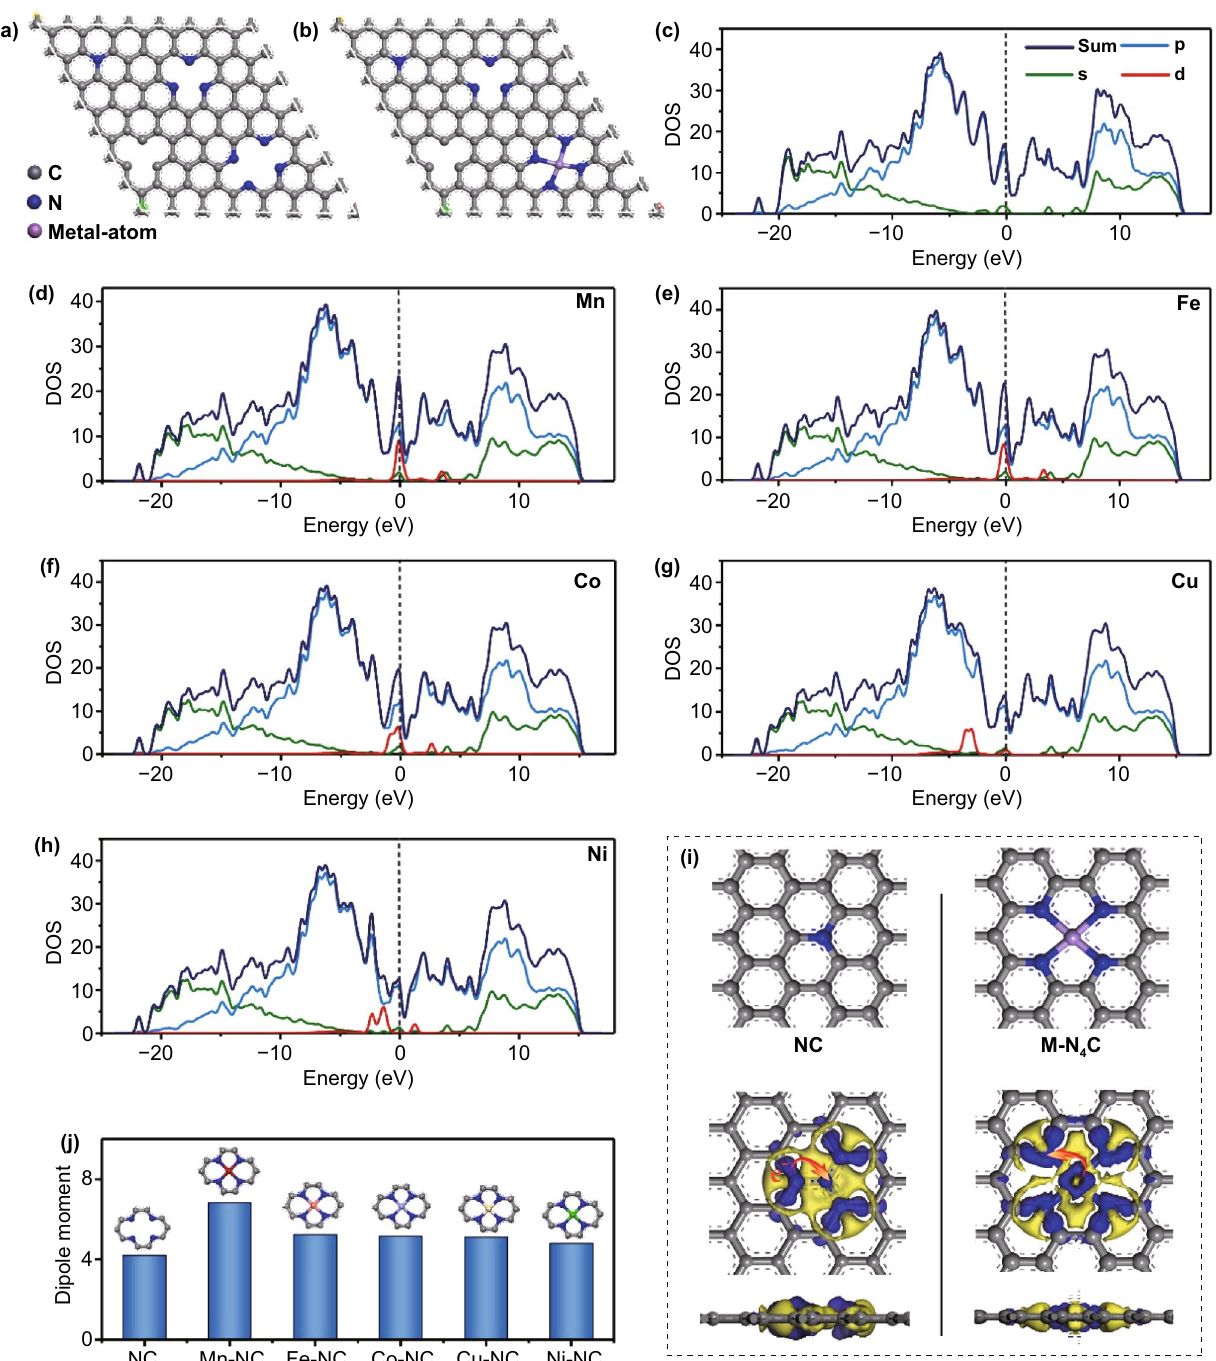
Fig. 6 Schematic structural models of a NC and b M–N 4 C structures. c–h Calculated DOS of the NC and M–N 4 C structures. i Calculated charge density difference of the NC and Mn–N 4 C structures. j Calculated dipole moment of the NC and M–N 4 C structures (M = Mn, Fe, Co, Cu, or